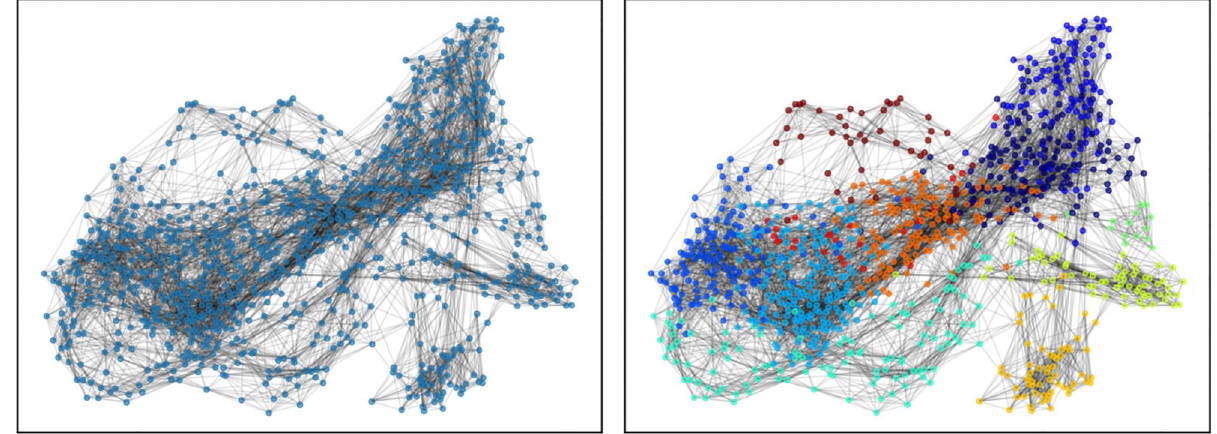
Fig 8. Similarity graph and community assignment. Pruned similarity graph without (left) and with (right) community assignment of the nodes as characterized in column A of Table 1. The neon yellow community corresponds to China-focused venture capital firms ( A6 ), the dark red community to India and Japan-focused venture capital firms( A10 ), the gold community to Health Care specialists ( A7 ), the blue community (far left) to accelerators ( A2 ).